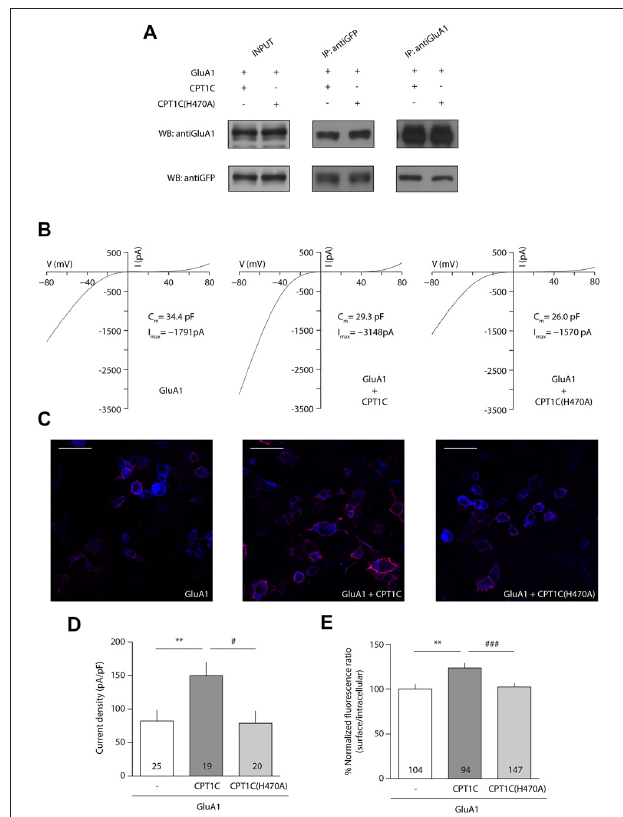
FIGURE 4 | Histidine 470 is crucial in CPT1C-mediated AMPAR effect. (A) Western blot showing that mutated CPT1C(H470A) interacts with GluA1. Anti-GFP antibodies could pull-down GluA1 when expressed together with CPT1C or CPT1C(H470A), (middle lanes, upper panel). GluA1 recognizing antibodies pull down both CPT1C and CPT1C(H470A), (right lanes, lower panel). This experiment was replicated three times. (B) Whole-cell GluA1-mediated currents between –80 mV and +80 mV in three example cells with similar membrane capacitance transfected with GluA1 alone (GluA1+GFP; left trace), together with CPT1C (middle trace) or CPT1C(H470A), (right trace). (C) Representative confocal images of tsA201 cells co-transfected with GluA1+GFP (left panel), GluA1+CPT1C (middle panel) or GluA1+CPT1C(H470A), (right panel). Surface and intracellular GluA1 were labeled with anti-GluA1-NT and Alexaflour 555 (red signal) or Alexaflour 647 (blue signal) as described in “Materials and Methods” section. Scale bars: 50 µ m. (D) Average of normalized currents at –80 mV for the three conditions shown in (B) . CPT1C increased GluA1-mediated currents ( ∗∗ p < 0.01; Mann-Whitney-U-test) while removal of catalytic His 470 in CPT1C avoided the enhancement of the currents ( # p < 0.05; Mann-Whitney-U-test). Numbers in bars denote the number of recordings. (E) Quantification of the GluA1 surface to intracellular ratio normalized to GluA1 and expressed as a percentage. The increment in surface expression due to CPT1C ( ∗∗ p < 0.01; Mann-Whitney-U-test) was abolished when catalytic His 470 was neutralized ( ### p < 0.001; Mann-Whitney-U-test). Numbers in bars denote the number of analyzed cells from three different IF